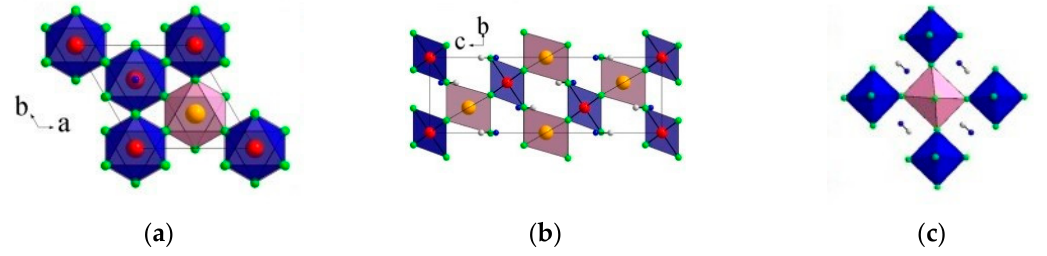
Figure 3. Crystal structure of (MA) 2 KBiCl 6 , obtained from single crystal X-ray diffraction, viewed along ( a ) the c axis, ( b ) the a axis, and ( c ) tilted to show the MA location. Red: Bi, brown: K, green: Cl, white: C, blue: N. BiCl 6 and KCl 6 octahedra are shown in blue and purple, respectively. Reproduced with permission from Reference [38]. Royal Society of Chemistry, 2016.